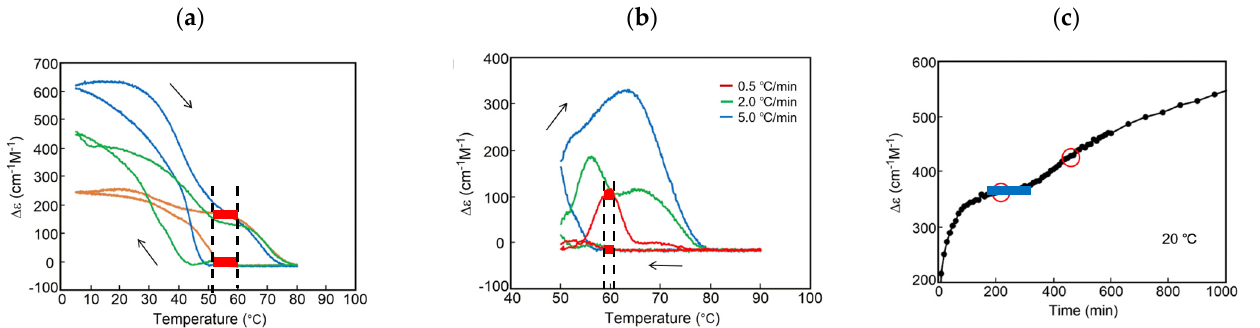
Figure 15. ( a ) Thermal hysteresis of ( M )– 5 and ( P )– 6 in toluene (0.5 mM) between 80 and 5 °C at rates of 0.5 (yellow), 2.0 (blue), and 3.0 (green) K min − 1 . ( b ) Thermal hysteresis between 90 °C and 50 °C at rates of 0.5, 2.0, and 5.0 K min − 1 . ( c ) Chemical kinetics at 20 °C. Red bold lines indicate bistability. Red circles indicate inflection points. Blue bold line indicates metastable state. Reproduced from ref. [62] with permission from Wiley.